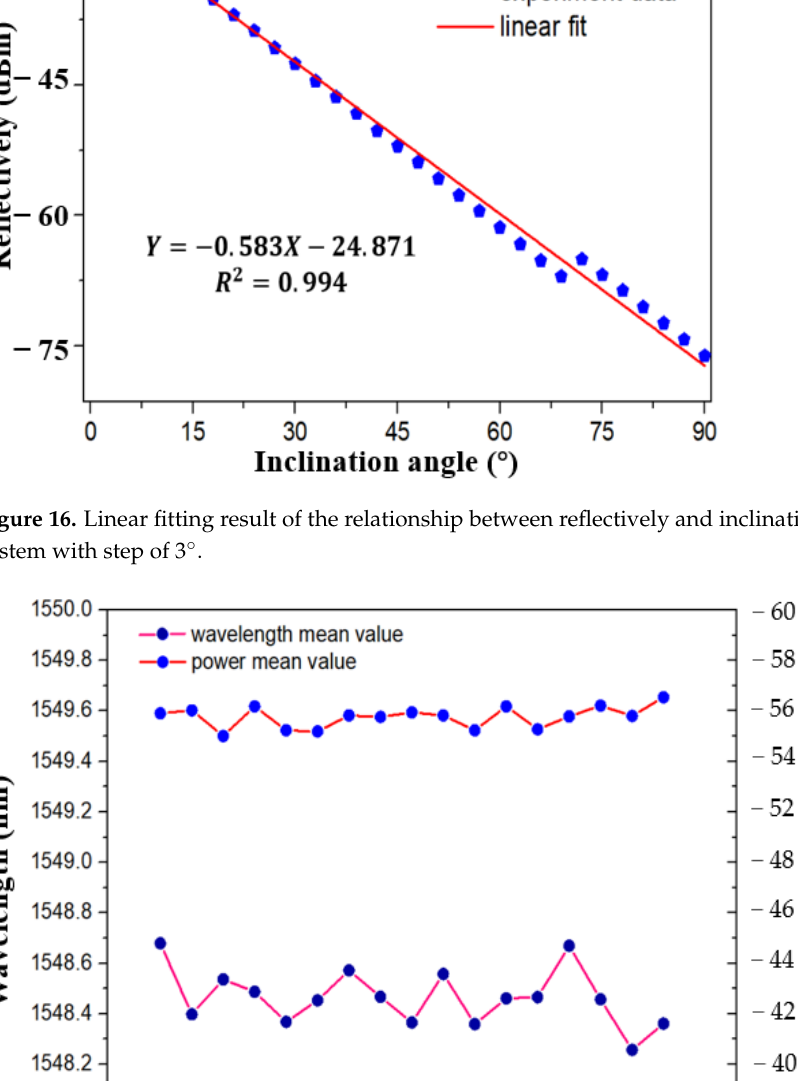
Table 1. The detection range comparation with other optical fiber inclinometer.